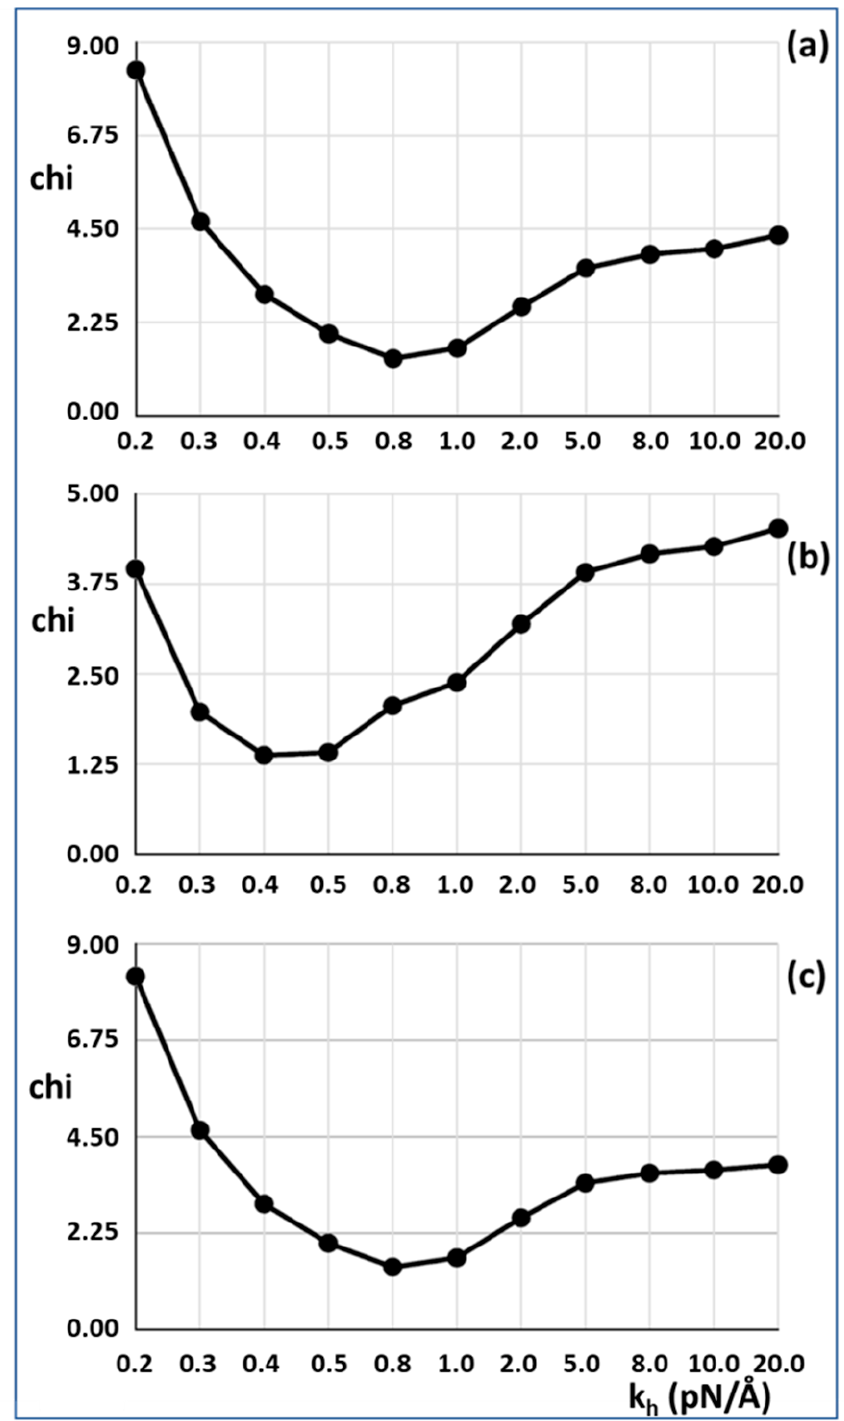
Figure 3. Results from Model 2 using optimised searching for good fits as measured by a goodness of fit factor Chi. The lower Chi is the better the fit. The best results were obtained with a cross-bridge stiffness k h around 0.45 to 0.8 pN/Å. ( a ) 30% attachment, ( b ) 50% attachment, ( c ) 30% attachment, with the T 1 intercept unconstrained. In ( a ) and ( b ) the T 1 intercept was constrained to be 40 Å. In ( c ) the value of the T 1 intercept was unconstrained, but it still came out at around 40 Å. Note the non-linear scale for k h.